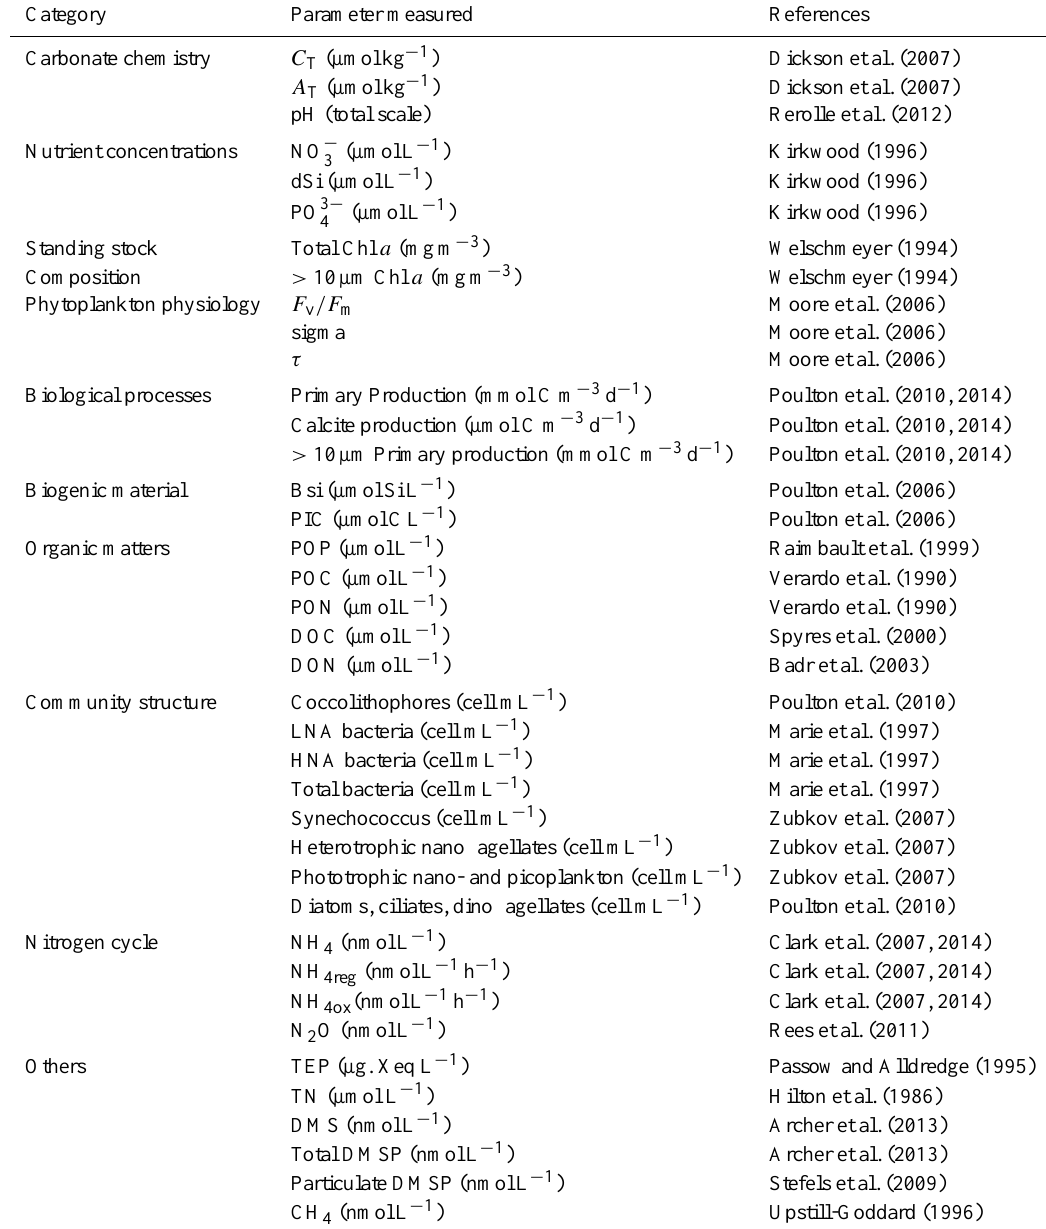
Table 3. Biological and chemical variables measured in each of the main bioassay experiments (Richier et al.,